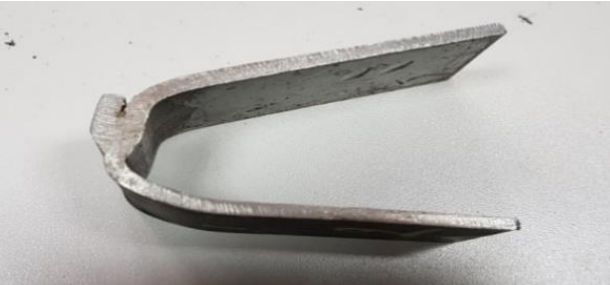
Figure 9: Bending test sample